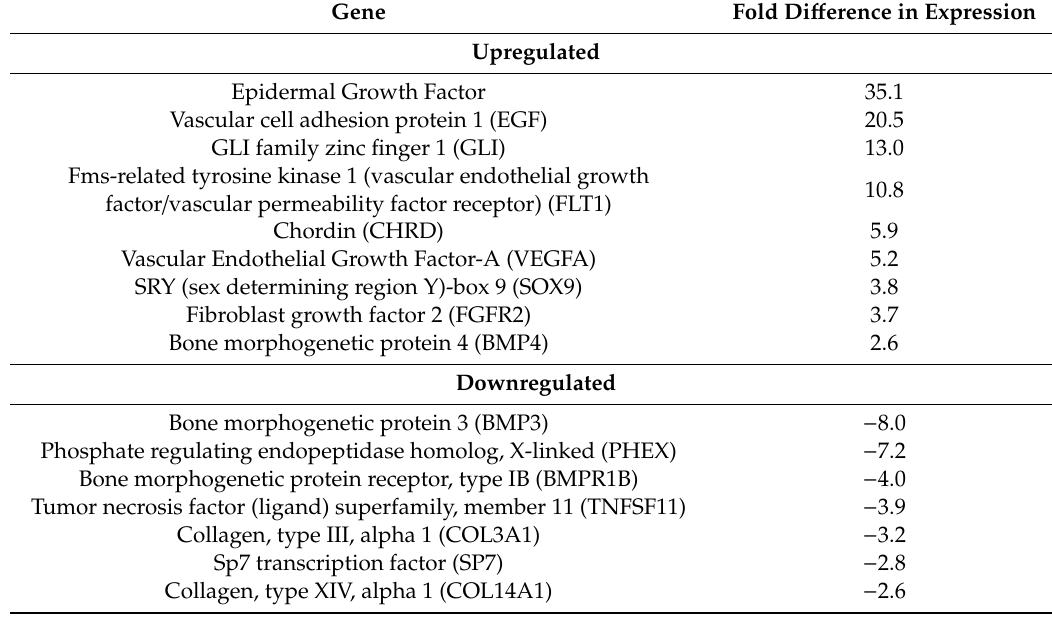
Table 3. Gene expression of autologous cells supplemented with fracture haematoma and peripheral